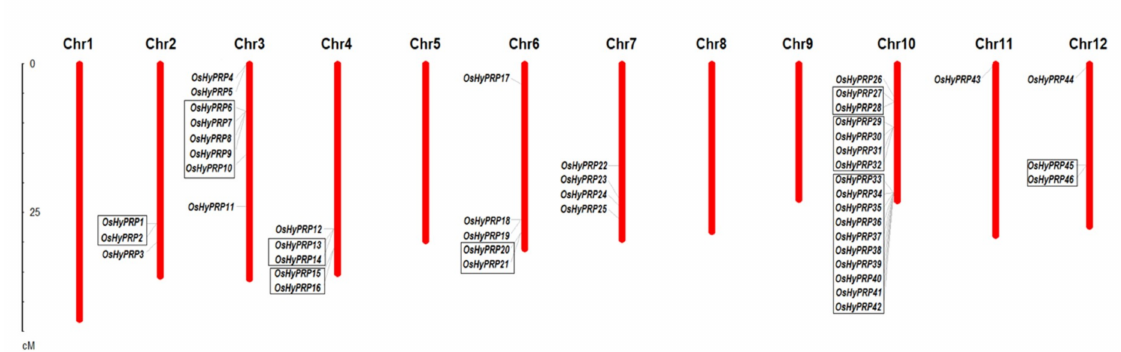
Figure 2. Chromosomal mapping and clustering of 46 OsHyPRP gene models in rice chromosomes. The boxes indicate the genes present within the region of 200 Kbp to form a gene